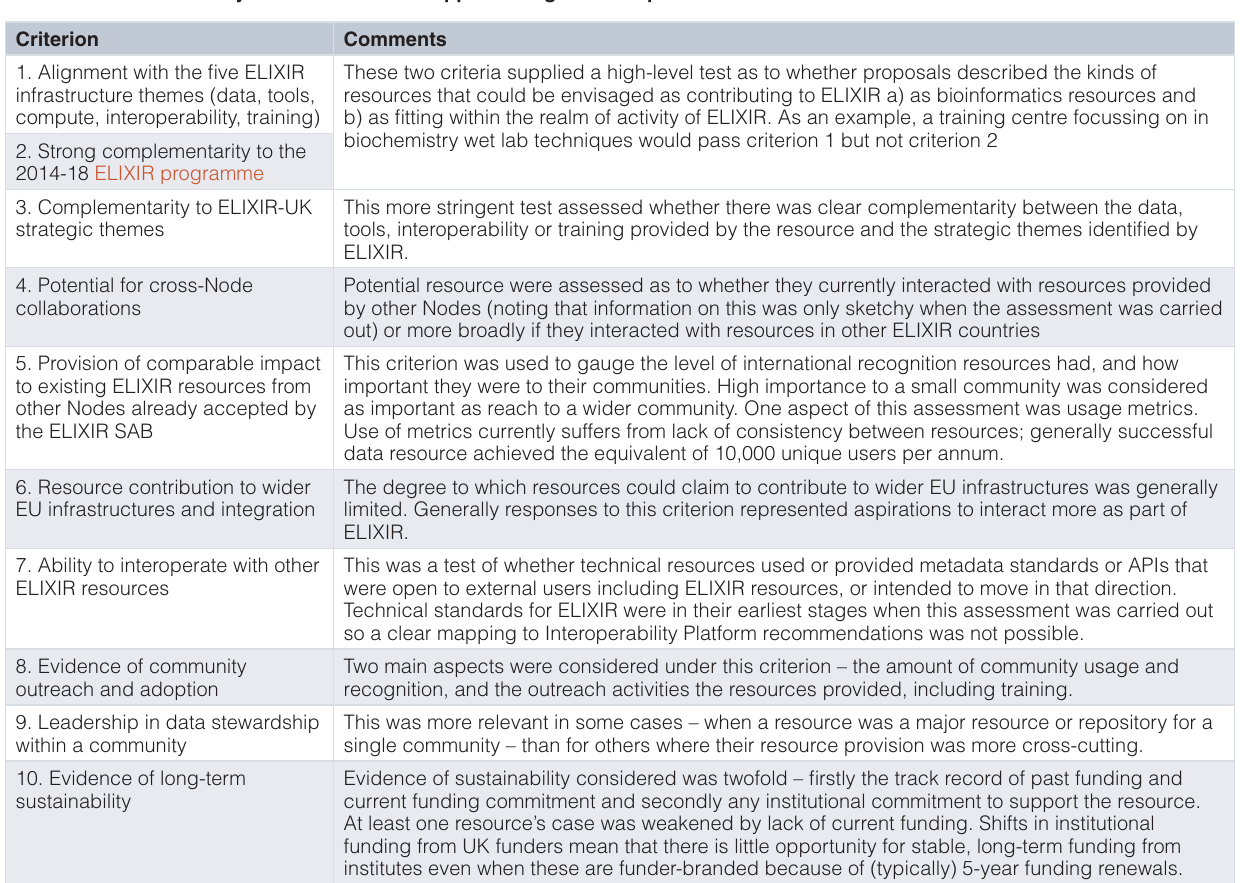
Table 1. Notes on the ways in which the SDG applied the general requirements of the ten assessment